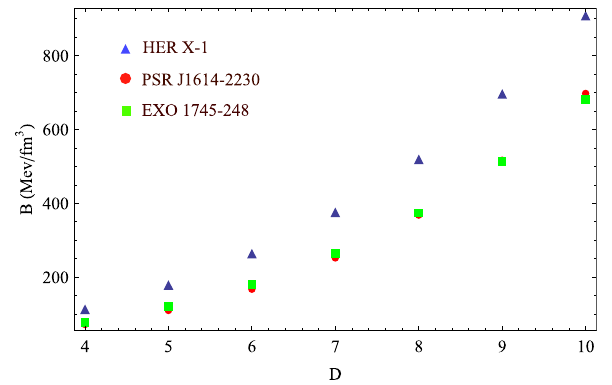
Fig. 19 Variation of bag parameter at the centre ( B (ρ 0 ) ) with dimen- sions ( D ) for different compact objects